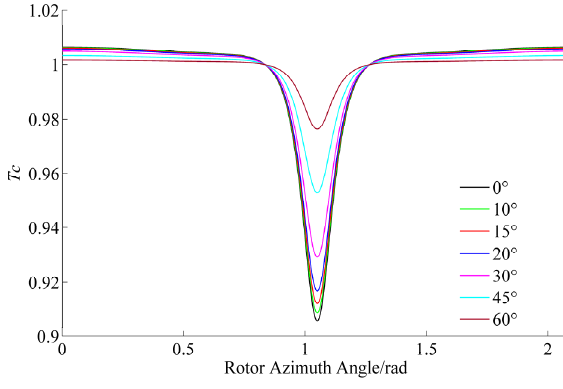
Figure 3. Effects of wind shear and tower shadow on the aerodynamic torque coefficient.